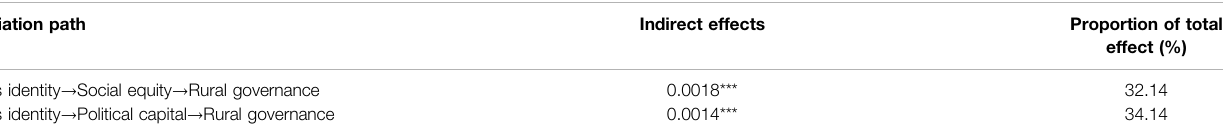
TABLE 5 | GSEM mediating effect